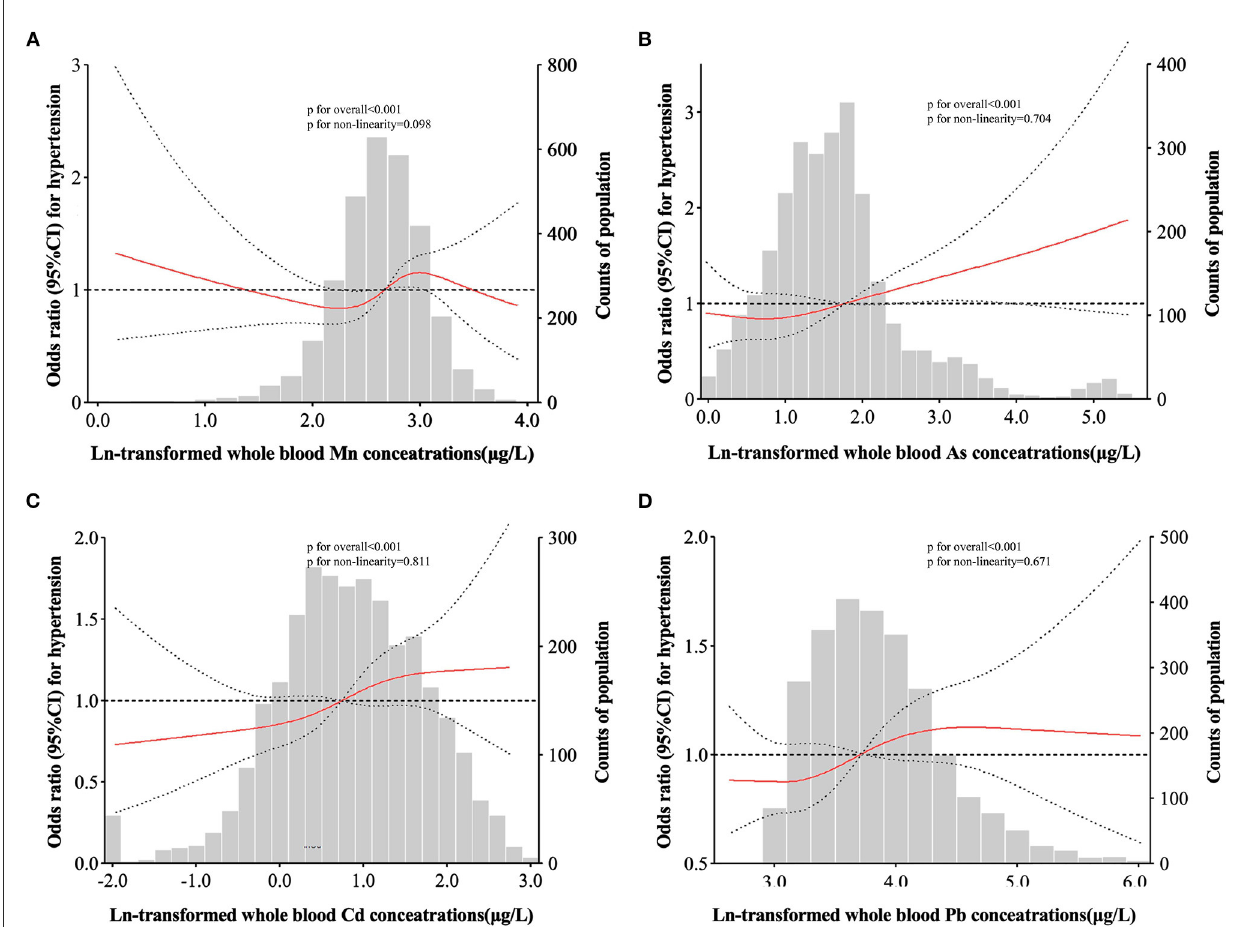
FIGURE1 Adjusted restricted cubic spline (RCS) for the association between blood metals and hypertension. The red lines indicate adjusted odds ratios and the black lines represent adjusted odds ratios [95% CI] based on RCS for the log-transformed levels of Mn (A) , As (B) , Cd ( C) , and Pb (D) in the single-metal models, with the reference value was set at the 10th percentile. Adjustment factors were age, sex, region, education level, drinking status, smoking status, family history of hypertension, antihypertensive use, BMI, TC, TG, and